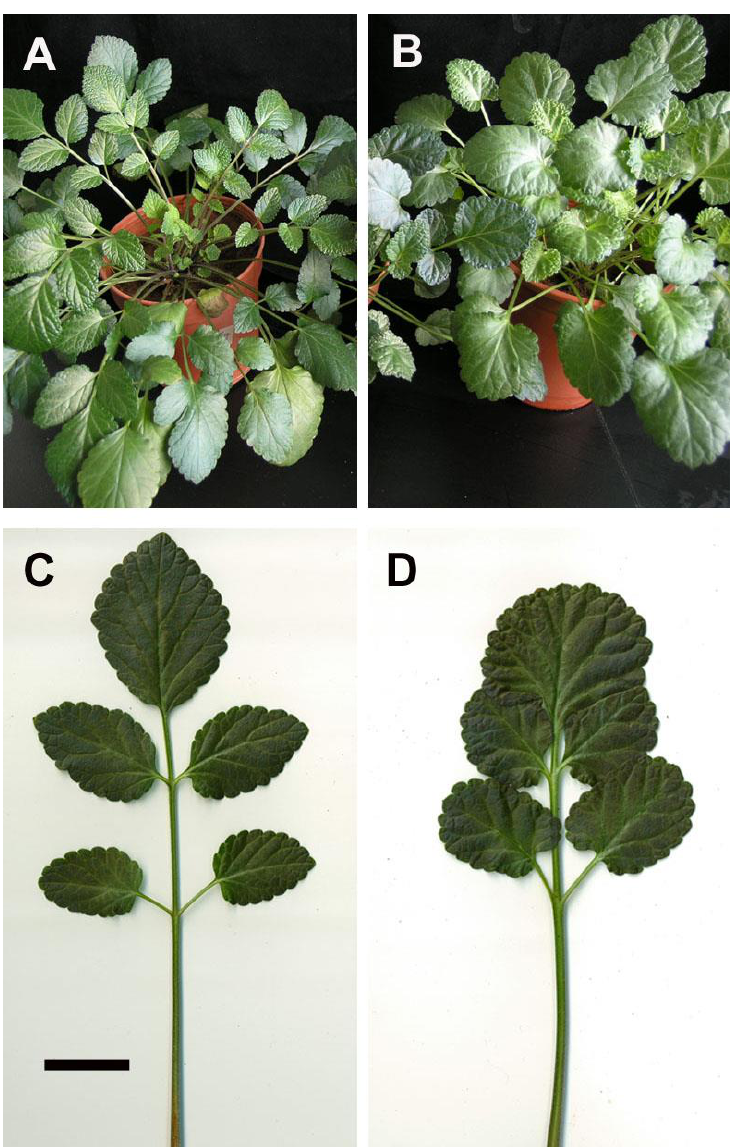
Figure 5. The 2 x and 4 x plants of Salvia miltiorrhiza after four months of culturing in pots (bar = 6.5 cm, 6.5 cm, 1.2 cm and 1.2 cm for Figure 5A – D, respectively). ( A ) A potted 2 x plant. ( B ) A potted 4 x plant. ( C ) A compound leaf of the 2 x plant. ( D ) A compound leaf of the 4 x plant. Table 4 Effect of polyploidy on morphology of leaflets in Salvia miltiorrhiza.